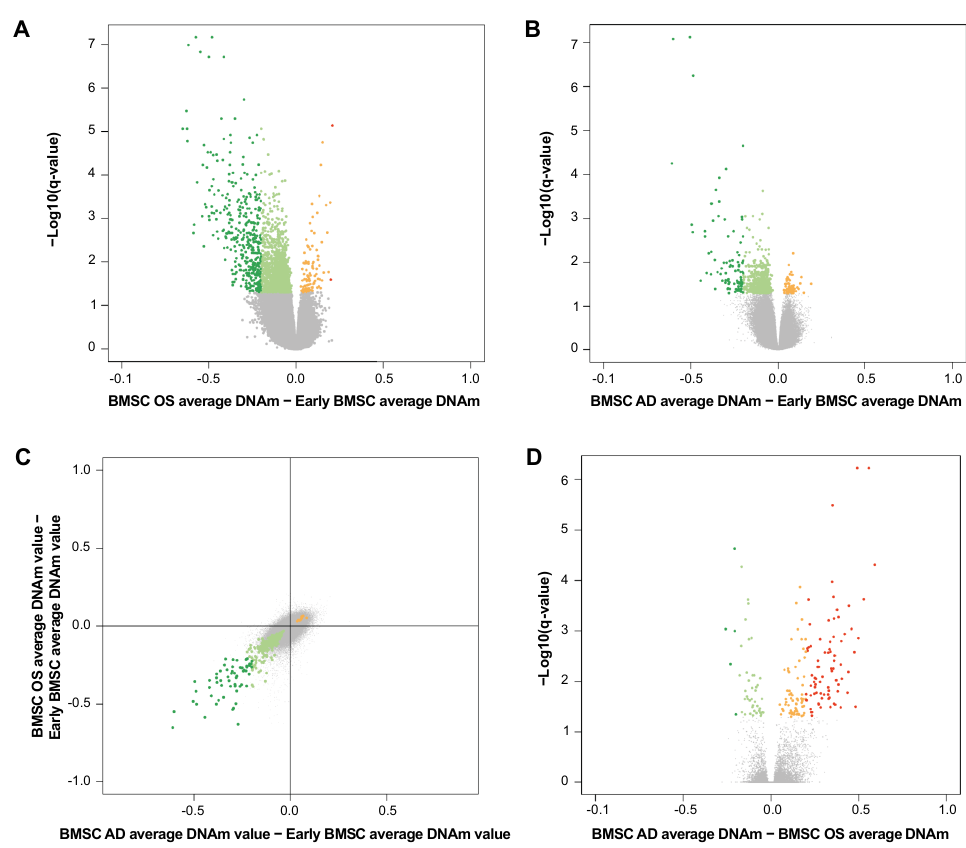
Figure 4. ( A , B , D ) Volcano plot showing differentially methylated CpGs (FDR < 0.05) in ( A ) osteoblasts (OS) vs. early BMSCs, ( B ) adipocytes (AD) vs. early BMSCs, ( D ) AD vs. OS. Differences in DNAm scores are plotted against −log 10 (q-values). DMPs with an absolute DNAm difference are highlighted in dark red (hypermethylated) and dark green (hypomethylated). ( C ) Scatter plot comparing DNAm differences associated to adipogenic differentiation ( x -axis) and osteogenic one ( y -axis). DMPs (FDR < 0.05) with hypo- and hyper-methylation in both the comparisons are indicated in green and red, respectively; DMPs with an absolute DNAm difference >0.20 are highlighted with darker green and red colors.